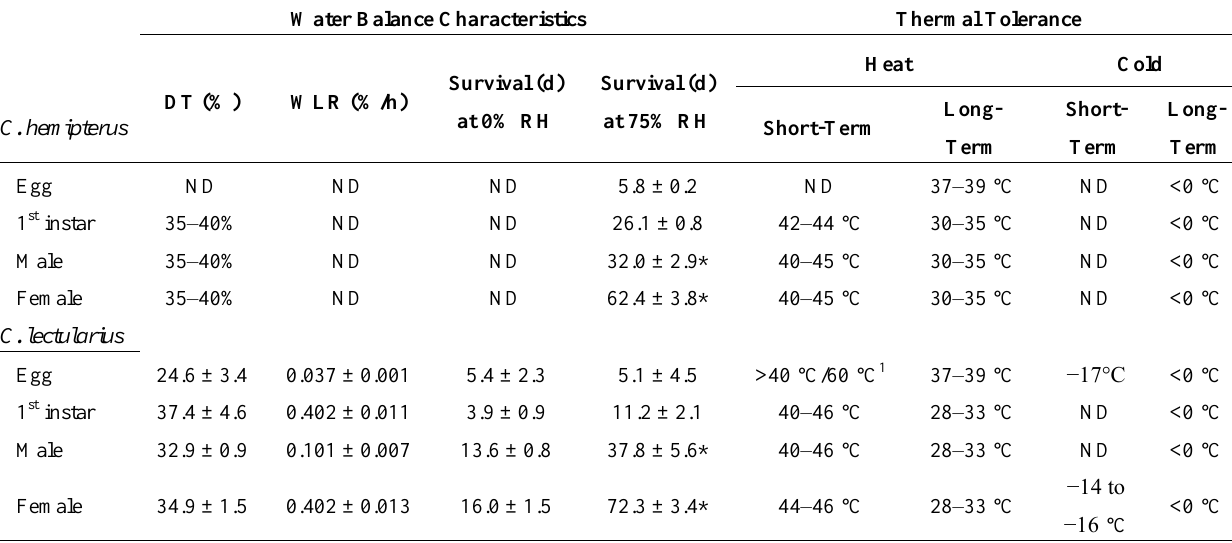
Table 1. Cold, heat and dehydration tolerance of the common bed bug, Cimex lectularius , and the tropical bed bug, C. hemipterus . DT, dehydration tolerance; WLR, water loss rate